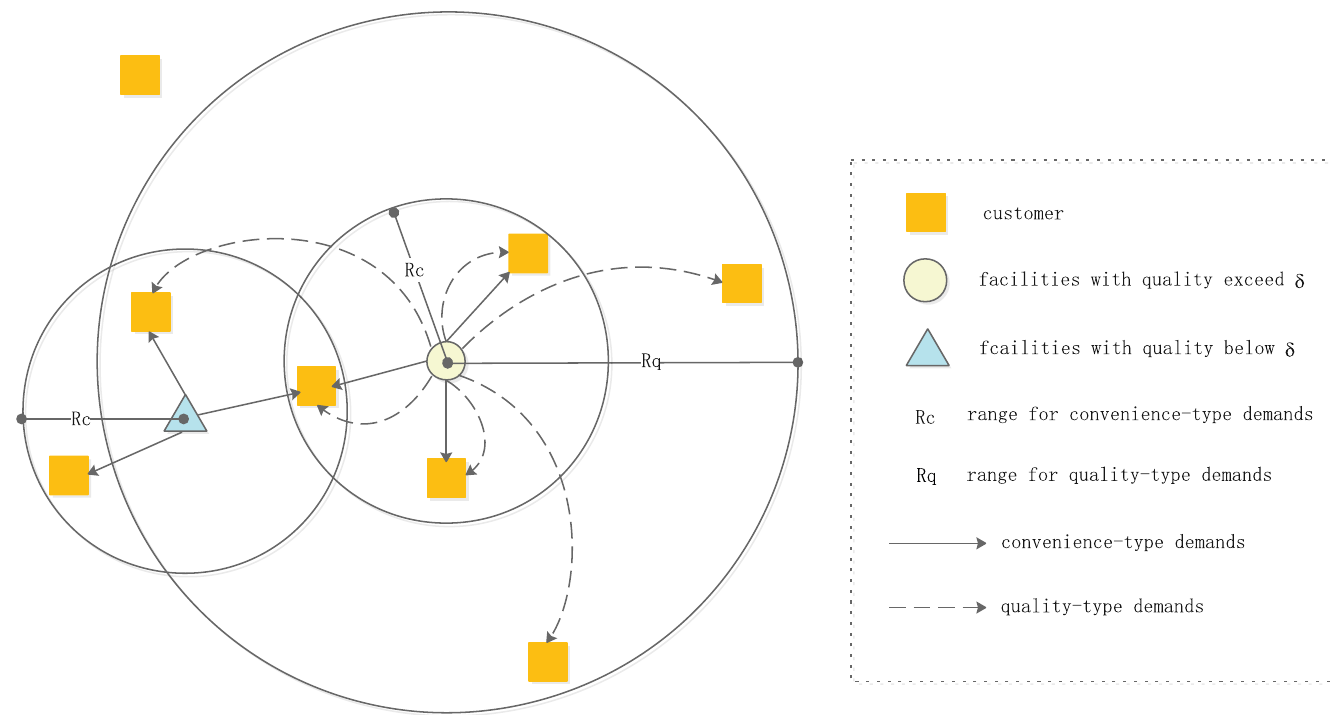
Fig 2. Patronage pattern from the perspective of